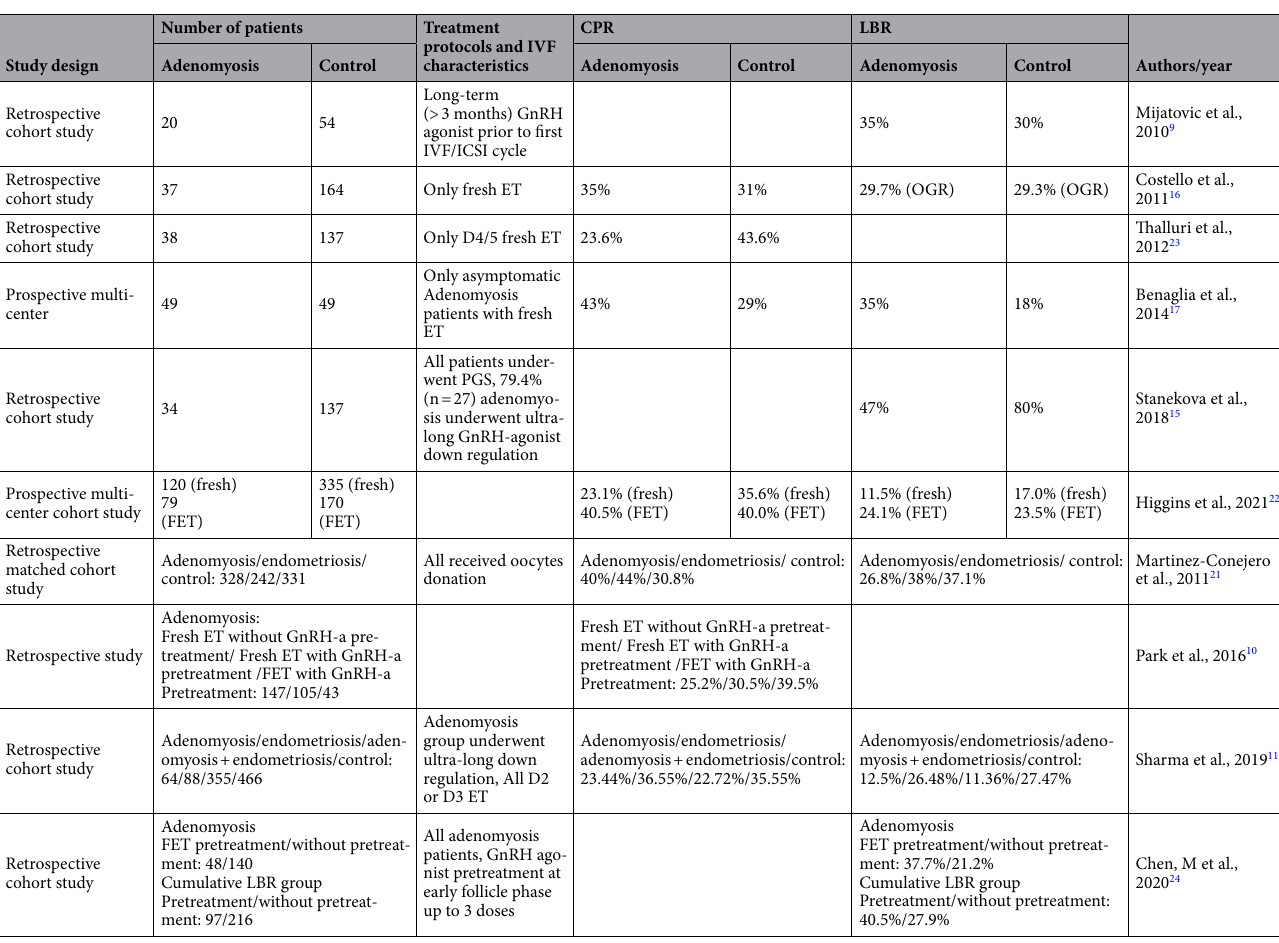
Table 5. Main characteristics of published studies on adenomyosis, endometriosis, and pregnancy